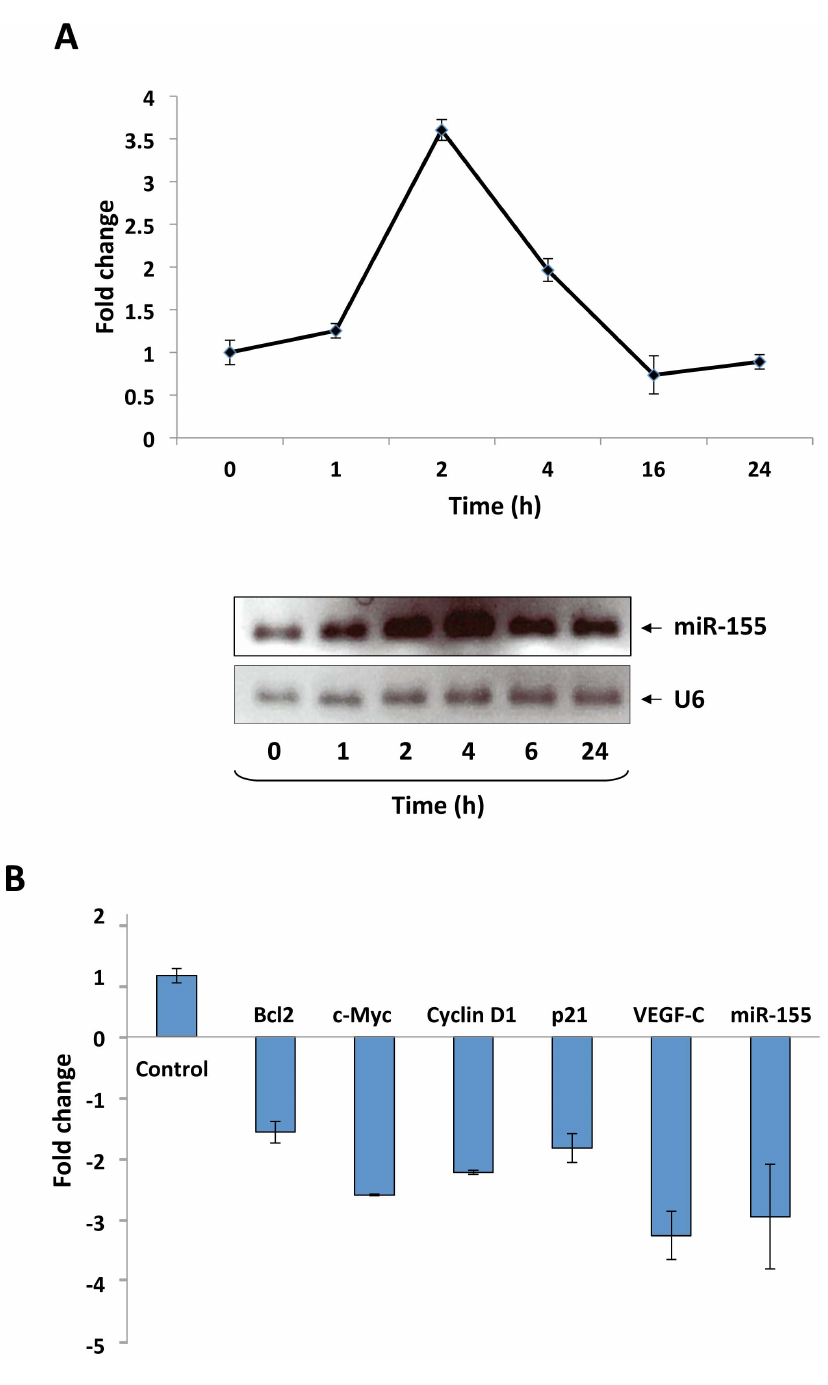
Figure 4. STAT3 activates miR-155 in CLL cells. A, CLL cells were incubated for 20 minutes with 30 ng/ml rhIL-6. Following incubation, cells were collected at different times, and total RNAs were prepared. qRT-PCR (upper panel) and RT-PCR (lower panel) revealed that IL-6 upregulated miR- 155 expression levels in a time-dependent manner. The U6 gene was used as an internal control for miRNA expression. B, Transfecting CLL cells with STAT3-siRNA at a transfection efficiency of 35% downregulated the expressions of miR-155 and the STAT3-regulated genes Bcl-2, c-Myc, Cyclin D1, p21/WAF1, and VEGF-C.